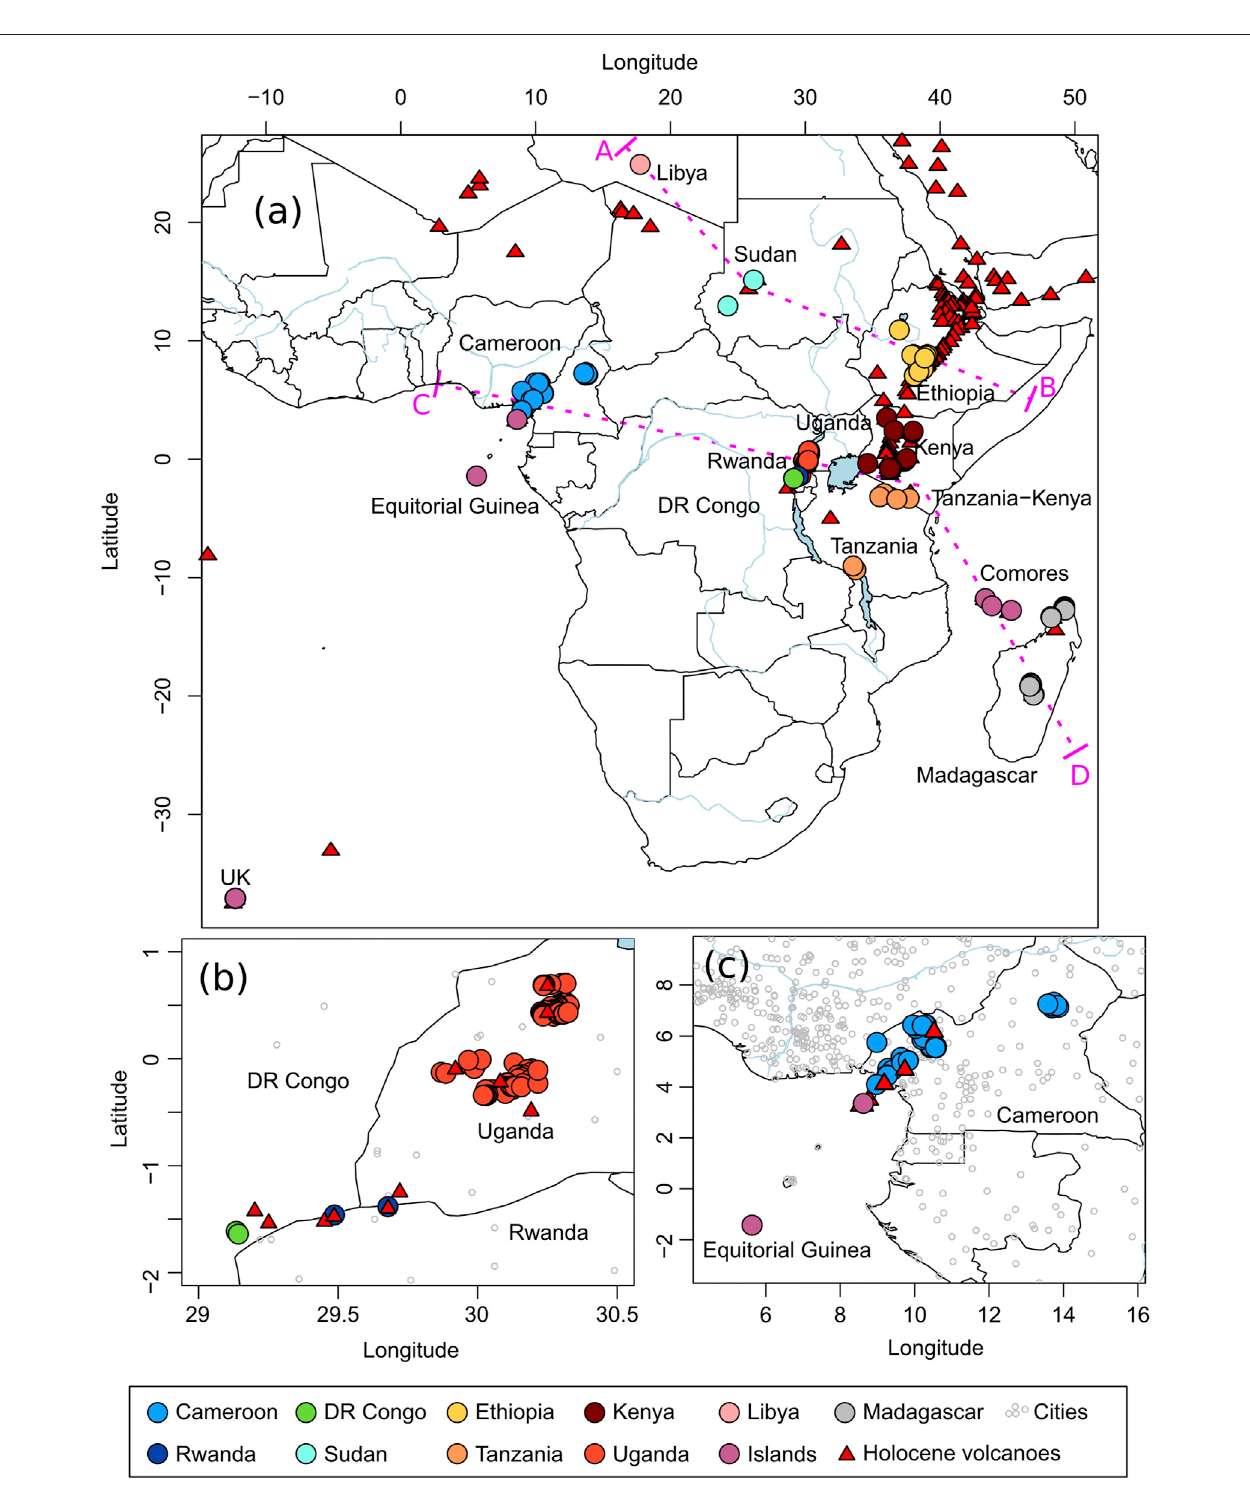
FIGURE1|(A) LocationmapoftheAfricanvolcaniclakes,color-codedpercountry.ThezoomedareamainlyshowsthelakesinBunyaruguru,Ndali-Kasenda and FortPortalvolcanic fi eldsinUganda (B) ,andtheCameroonVolcanicLine (C) .HoloceneactivevolcanoesareexportedfromtheGlobalVolcanismProgram-Smithsonian database (https://volcano.si.edu/).